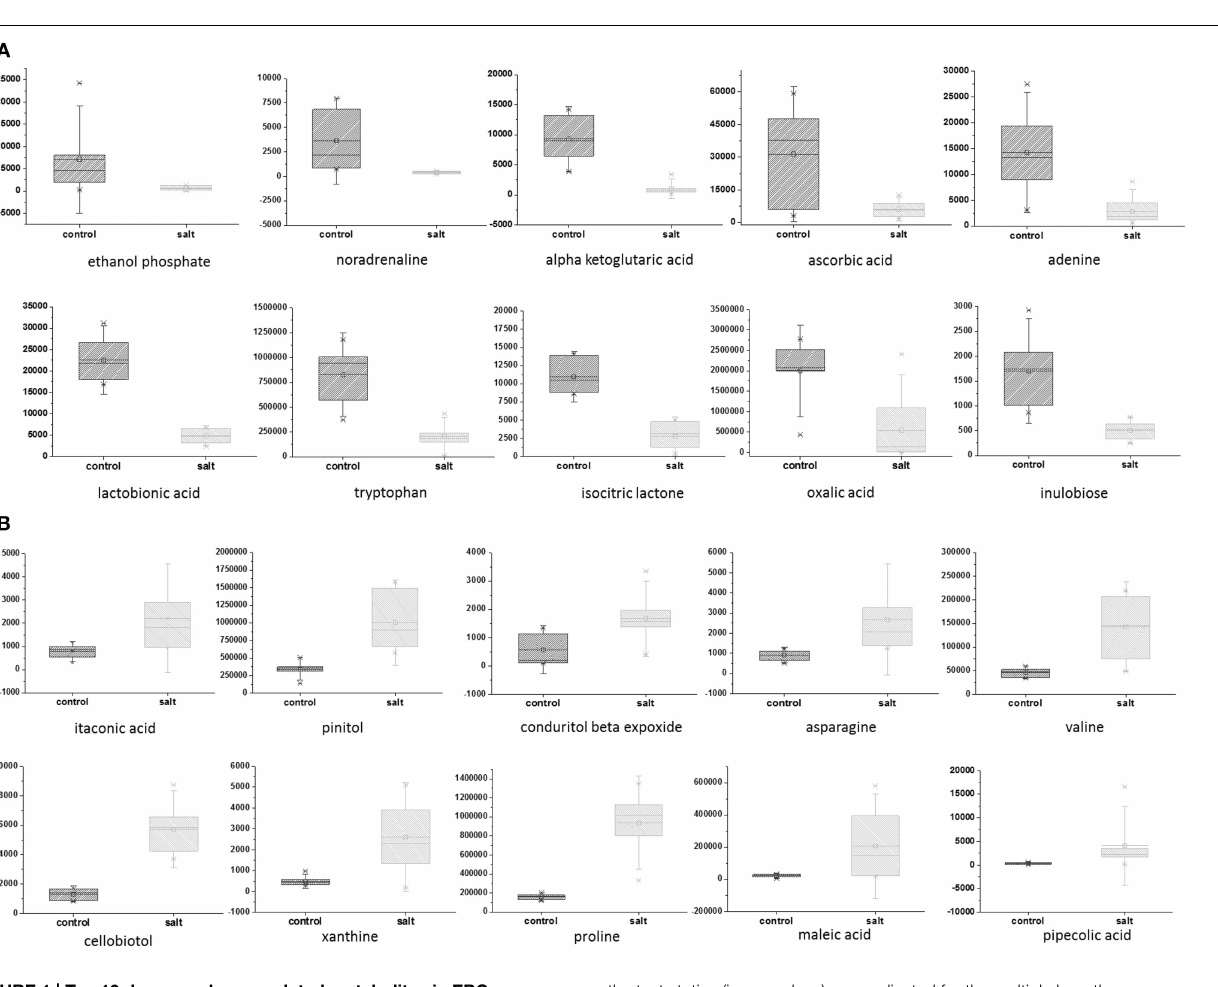
Frontiers in Plant Science |